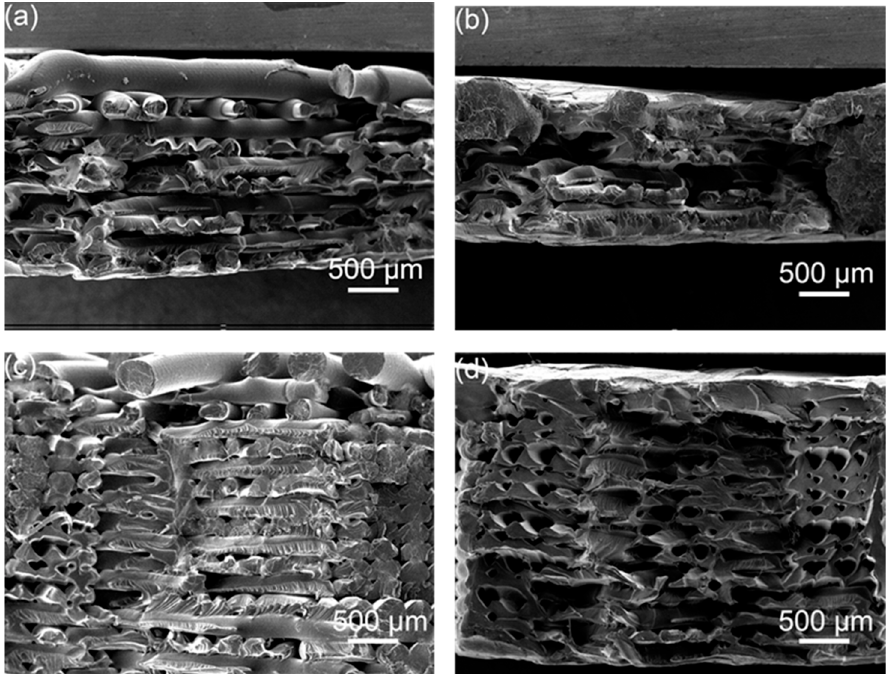
Figure 17. Cross-sectional view of the tensile sample, ( a ) 2 mm original, ( b ) 2 mm ultrasonically strengthened sample, ( c ) 3.5 mm original, ( d ) 3.5 mm ultrasonically strengthened sample.